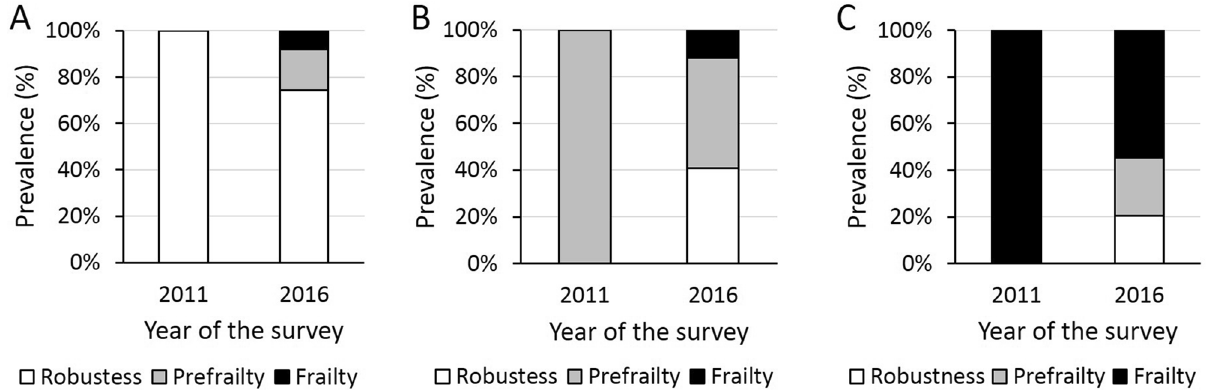
Figure 2. Transitions in frailty status by the status at the baseline. ( A ) Transitions in older adults who were robust in 2011. ( B ) Transitions in older adults who were prefrail in 2011. ( C ) Transitions in older adults who were frail in 2011.